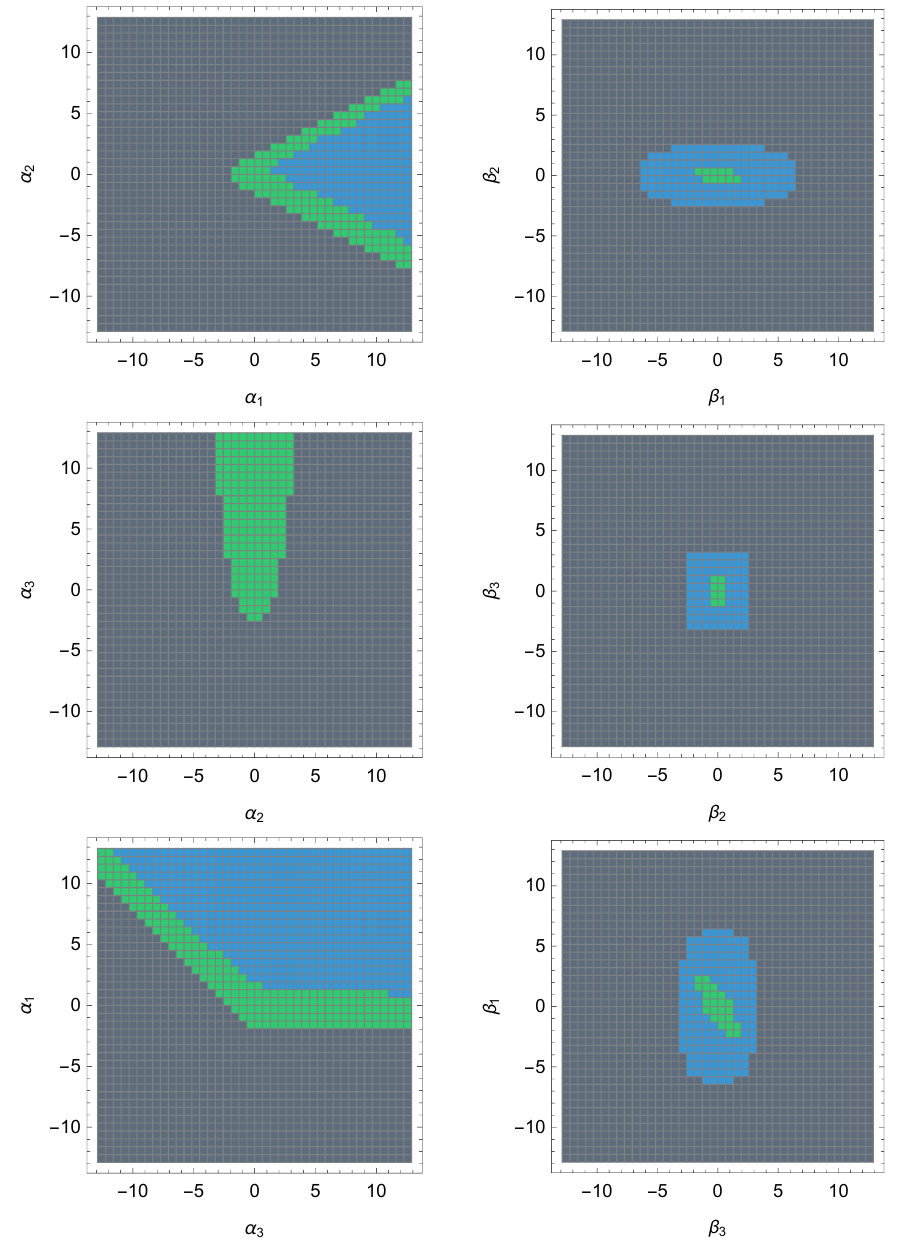
Figure 5 . Global minimum constraints on (cid:11) i and (cid:12) i . Samples in the green region have type E global minima so they will lead to successful symmetry breaking; the blue region violates the global minimum constraints which means that either the potential does not have type E minimum or its type E minimum is local; the black region violates the BFB condition. Other potential parameters, if not indicated by the plots, are (cid:12)xed at the benchmark values in eq. (5.3). The grid interval is 0 : 2 (cid:25)